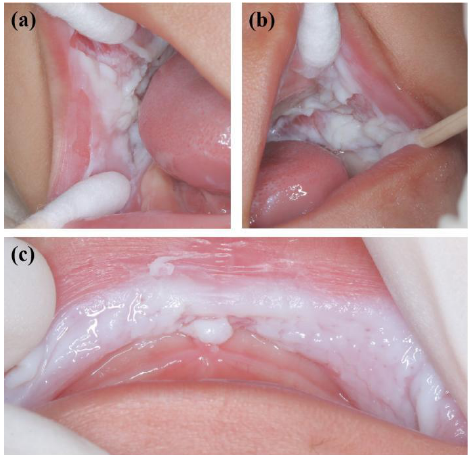
Figure 3. Oral manifestations of sister 1 showing large white corrugated folds in the ( a ) right and ( b ) left buccal mucosa and ( c ) inner mucosa of the upper lip, resembling a sponge.